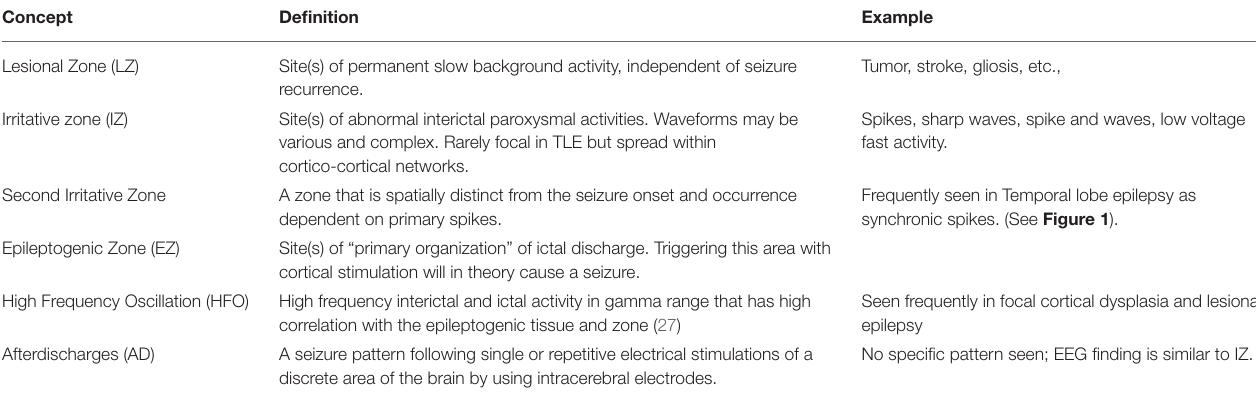
TABLE 1 | Definition of some commonly used terminology in stereo-encephalography (SEEG)